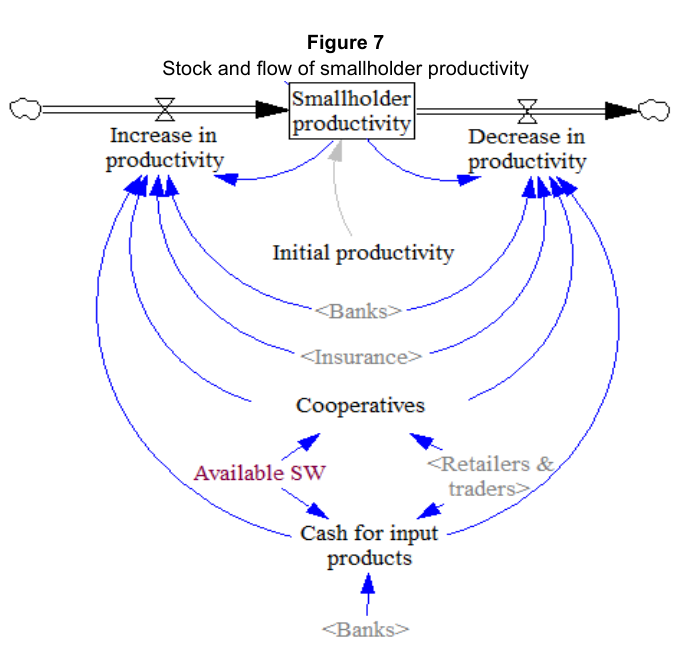
Stock and flow of smallholder